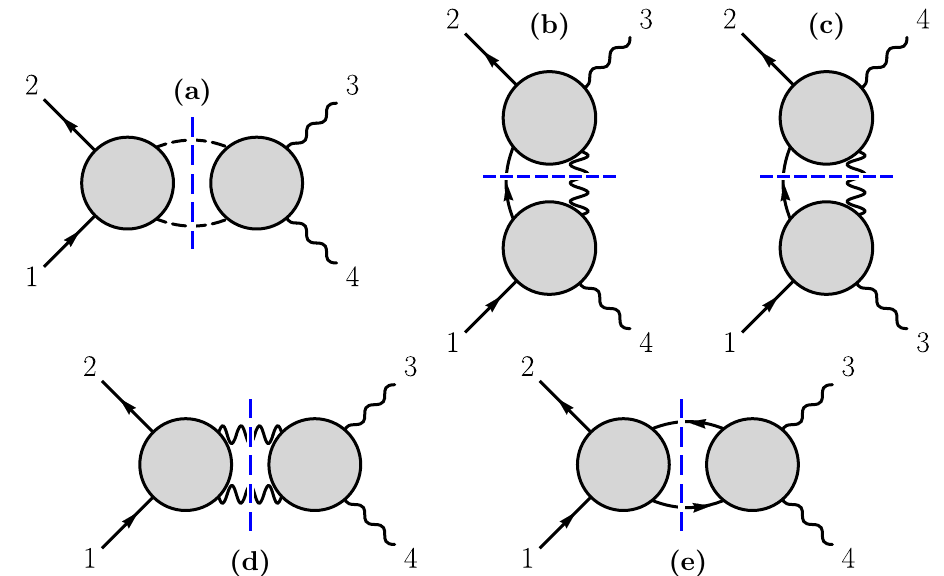
Figure 4 . The necessary cut for constructing a two-fermion, two-vector amplitude. For an ampli- tude with an insertion of a higher-dimension operator, one should insert the operator into either side of the diagrams when possible. The wavy lines are vector bosons, the lines with arrows fermions and the dashed lines